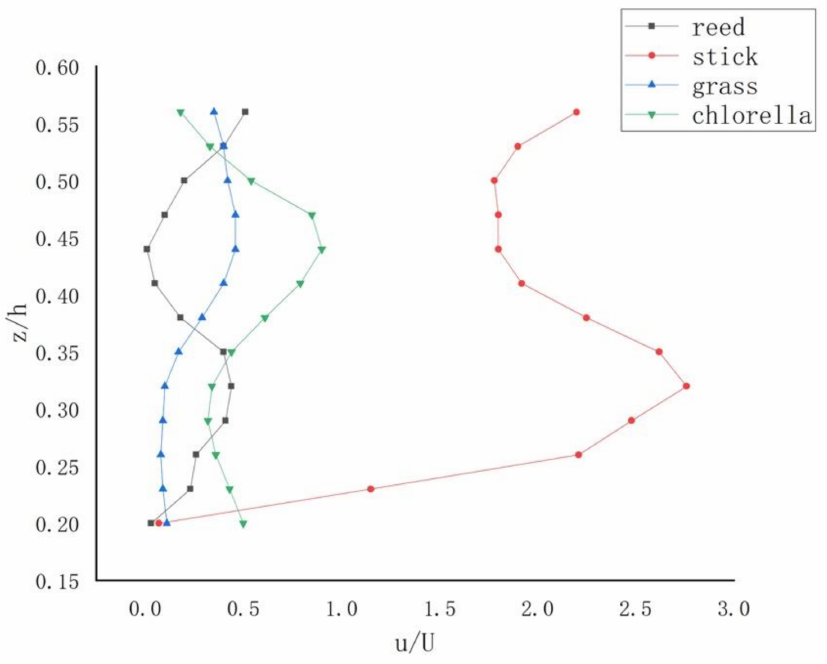
Figure 5. Vertical distributions of point velocity at vertical 4 with Q = 20 L/s for different vegetations: reed and stick at the length of 30 cm, grass at the length of 10 cm, and the chlorella at the length of 5–6